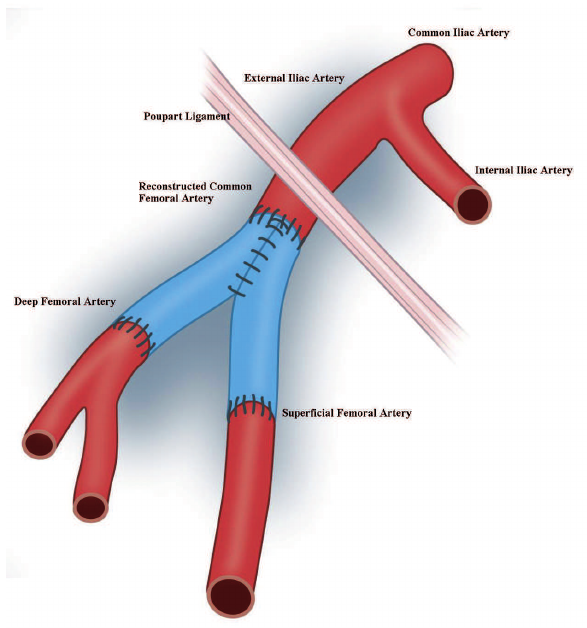
Fig. 2 - Ipsilateral saphenous vein harvested and transformed to a bifurcated interposition graft between the external iliac- and the superficial and deep femoral arteries